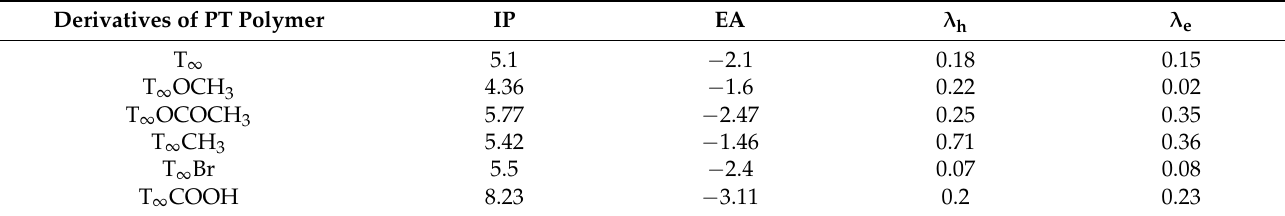
Table 4. Calculated IP, EA, λ h , and λ e of PT polymer derivatives.